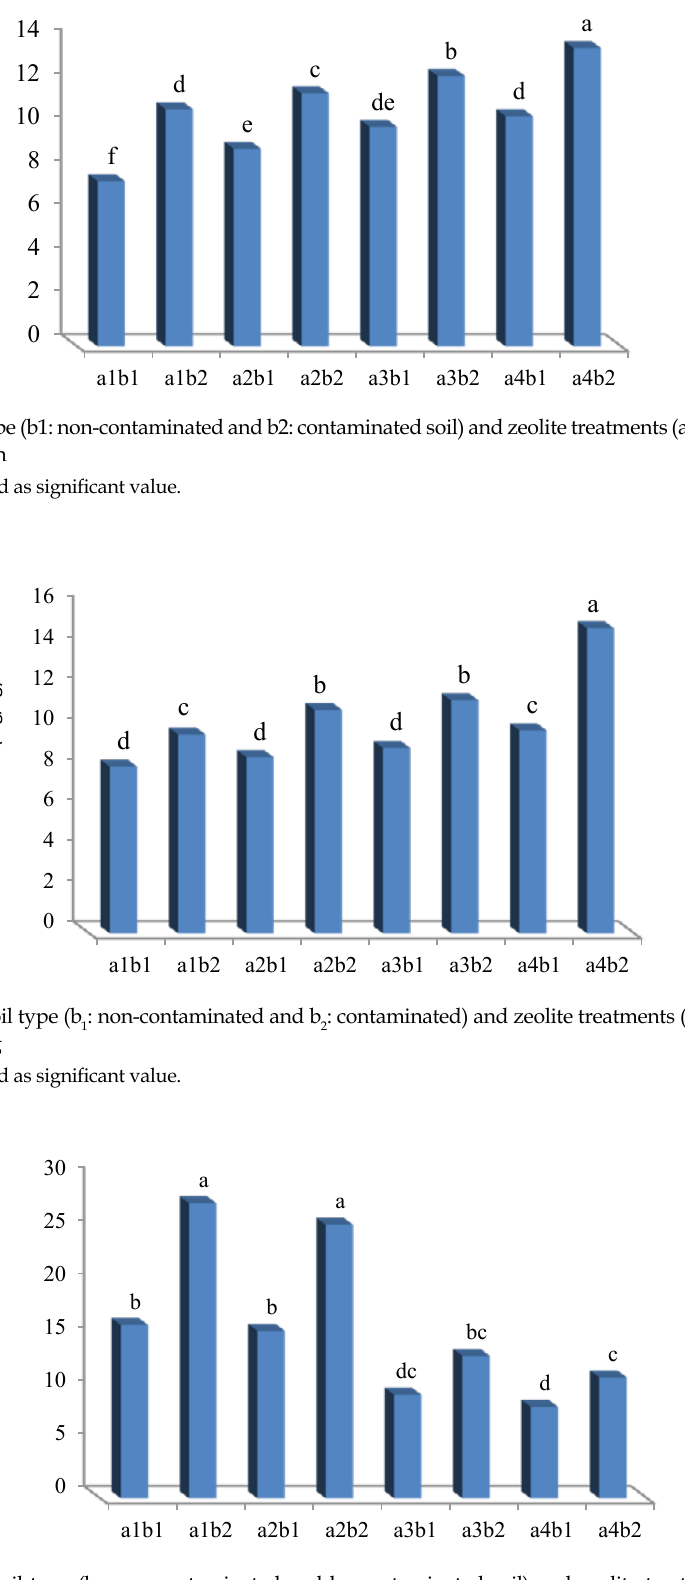
Figure 4. The effect of soil type (b Fig. 4. The effect of soil type (b 1 : non-contaminated and b 2 : contaminated soil) and b :1.5%, b :2.5%) on grain Zn 3 4